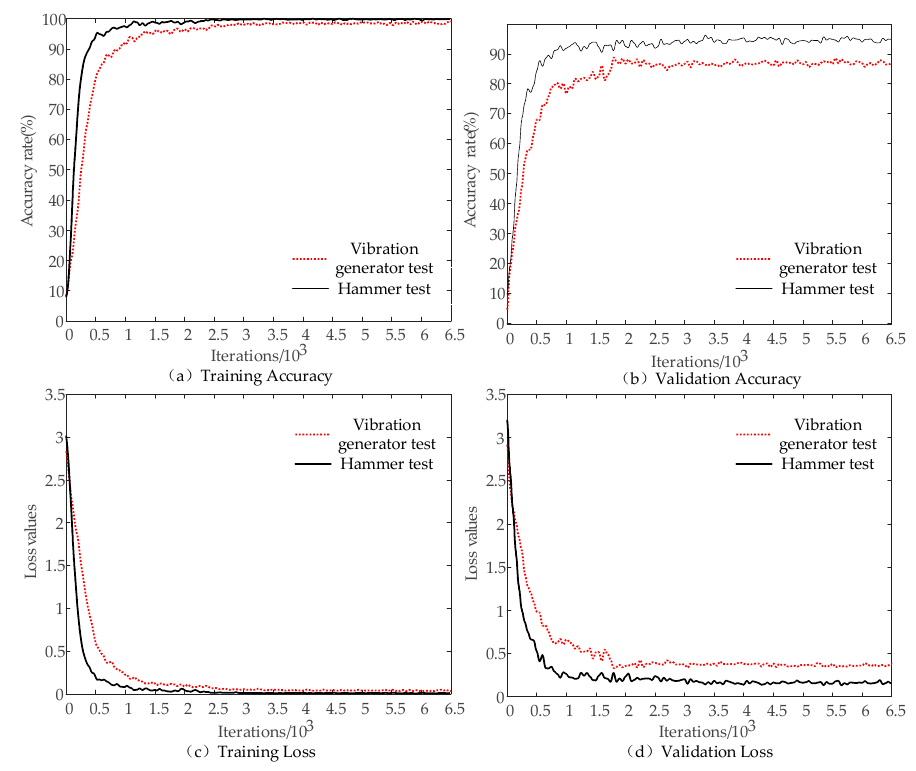
Figure 9. Comparison of different excitation forms on model performance of ResNet-50 model. ( a ) training accuracy; ( b ) validation accuracy; ( c ) training loss; and ( d ) validation loss.